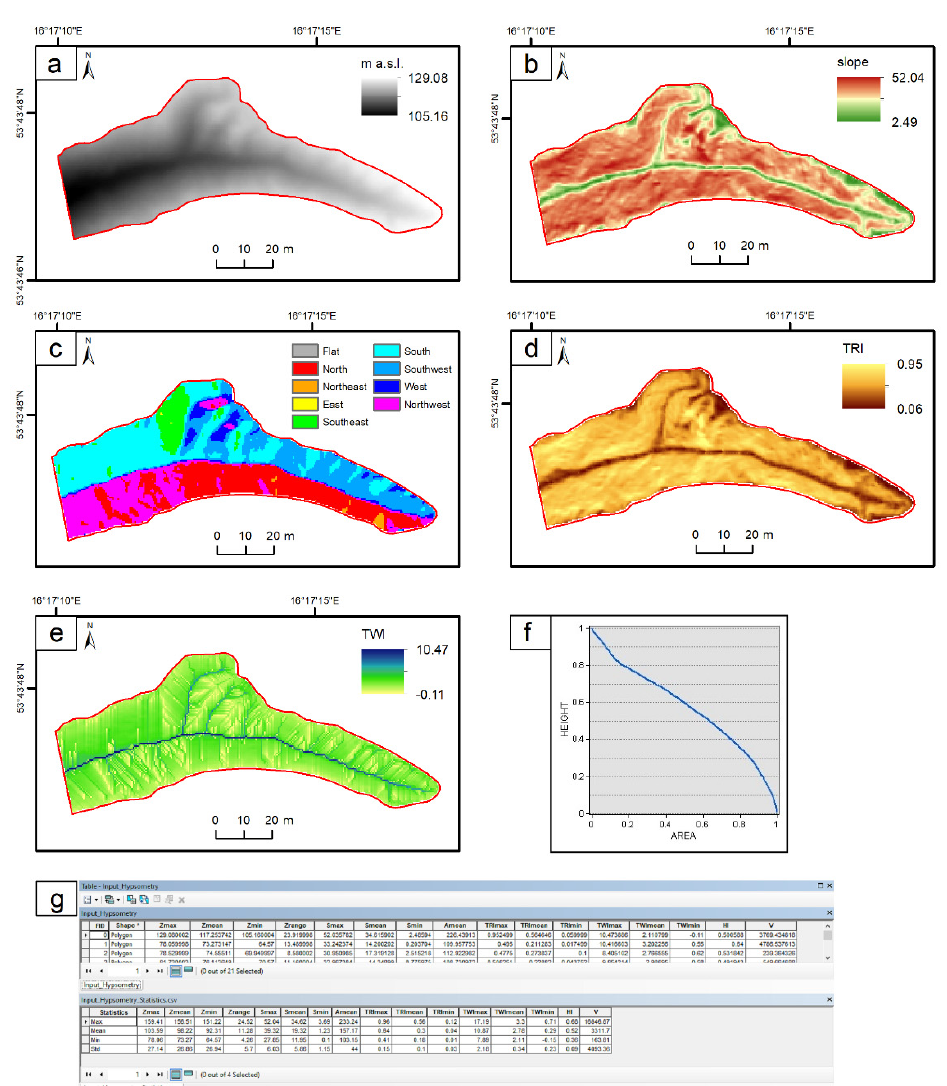
Figure 8. An example of a visualisation of the output data of the Hypsometry module: ( a ) DEM map; ( b ) Slope map; ( c ) Aspect map; ( d ) TRI map; ( e ) TWI map; ( f ) Hypsometric curve graph; ( g ) Attribute table of the output layer; descriptive statistics output table.